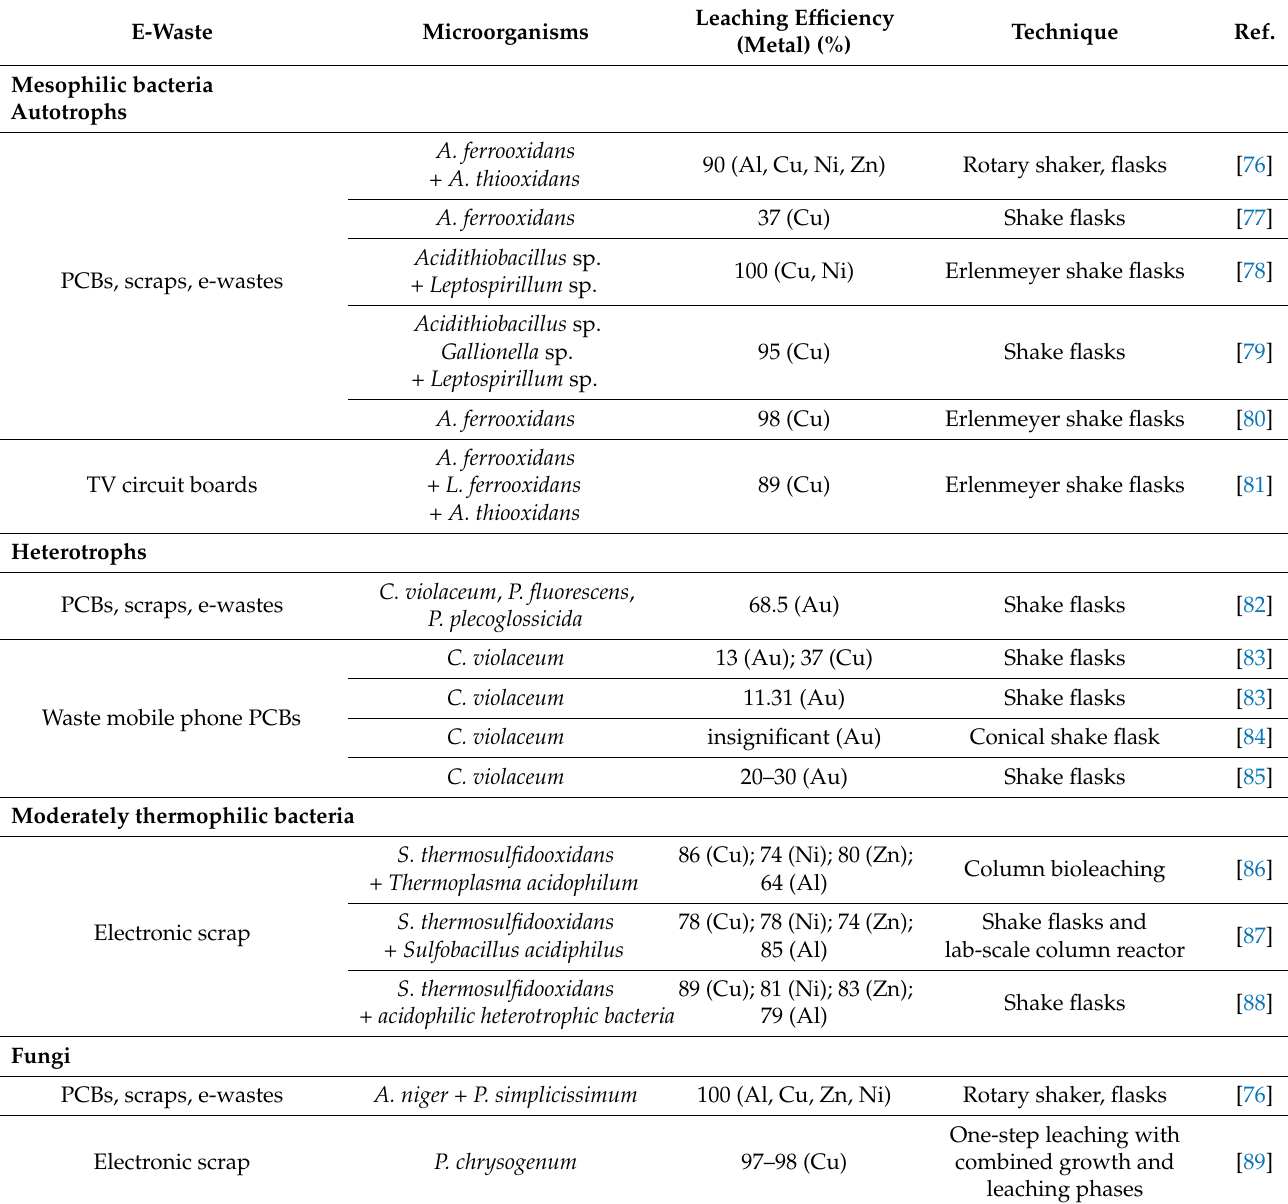
Table 2. The bioleaching recovery of metals from e-wastes along with utilized microorganisms, leaching efficiency, the type of e-waste, and the used techniques, reproduced from [70]. Leaching Efficiency Technique Microorganisms (Metal) (%)